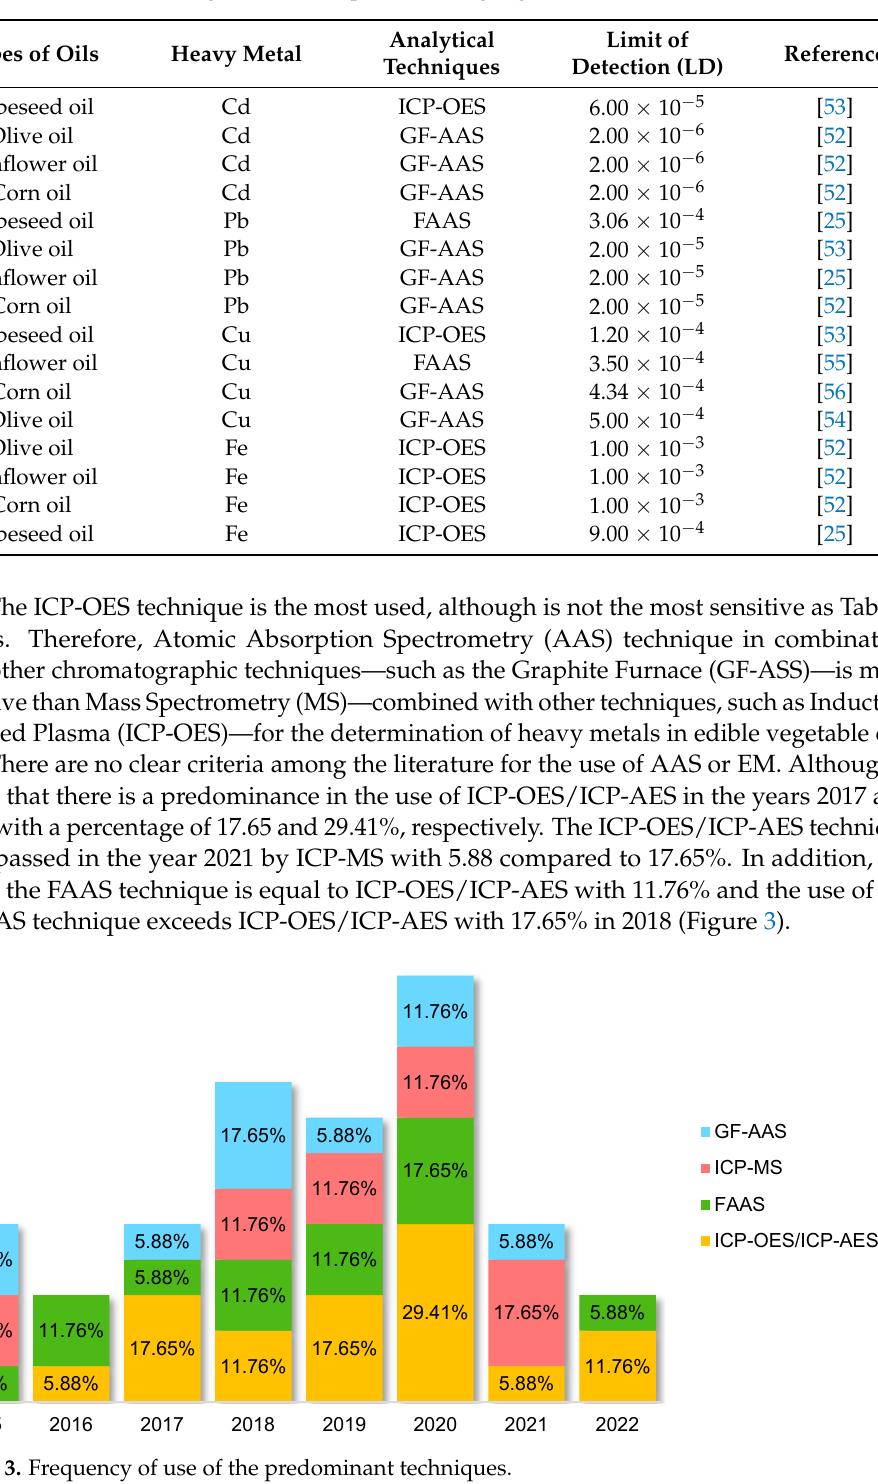
Table 1. Detection limits (LD) of the most widely used techniques for the determination of heavy metals and most studied vegetable oils, expressed in mg/kg.